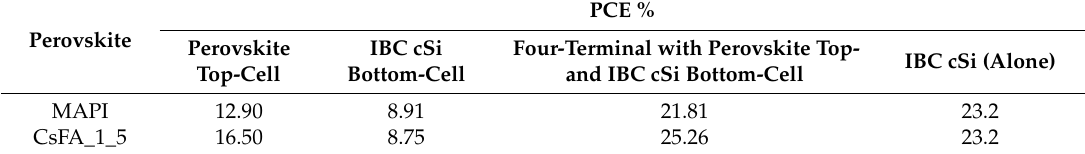
Table 1. The efficiencies of single sub-cells and four-terminal tandem device are presented based on experimental values from literature (reference [36] and reference [54]) for V oc and Fill Factor (FF), but simulated results for J sc (this study).